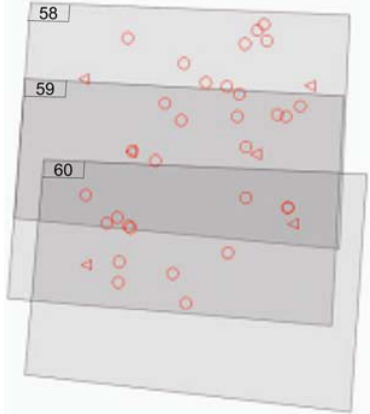
Figure 11. Distribution of ground control Points (triangles) and check points (circles) in the experiment with bundle adjustment.